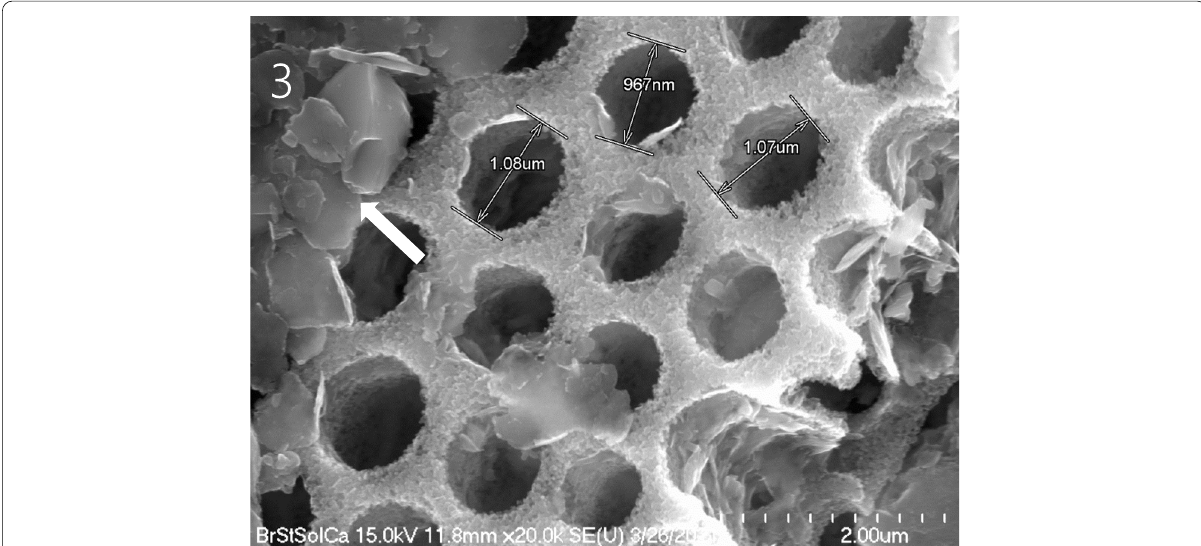
Fig. 3 High-magnification scanning electron micrograph of uniformly arranged circular pores of the frustule in diatom remnants. The areolae are arranged in regular patterns across the frustule surface. Arrow: Plate-shaped clay minerals